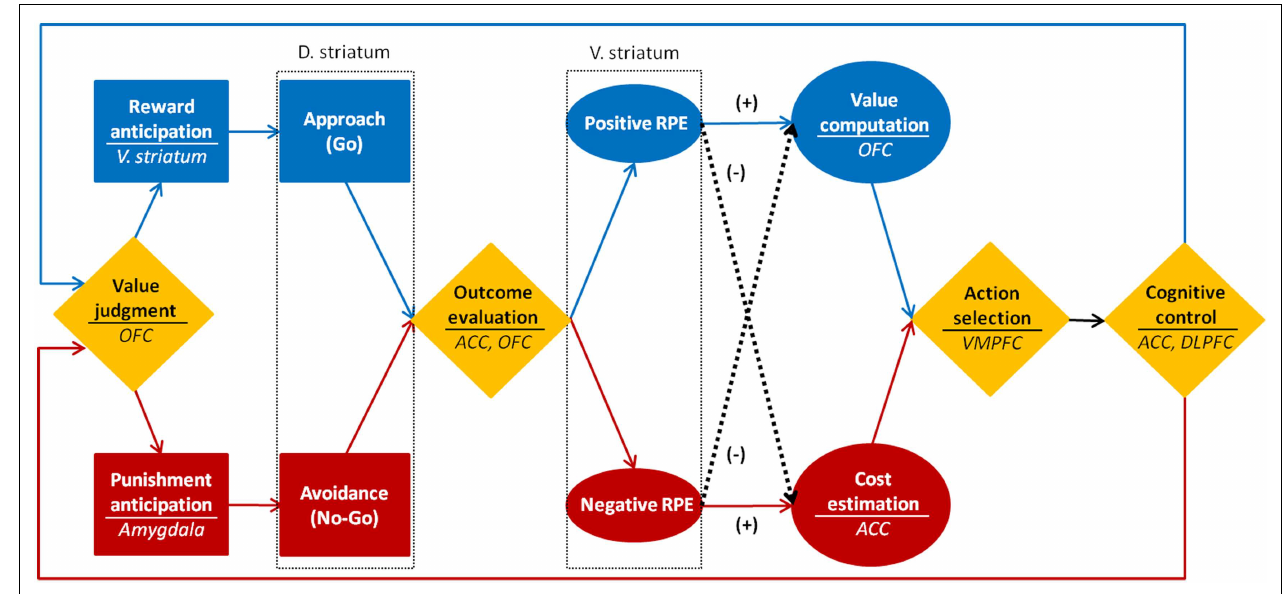
FIGURE 4 | Neuroscientific model of motivational